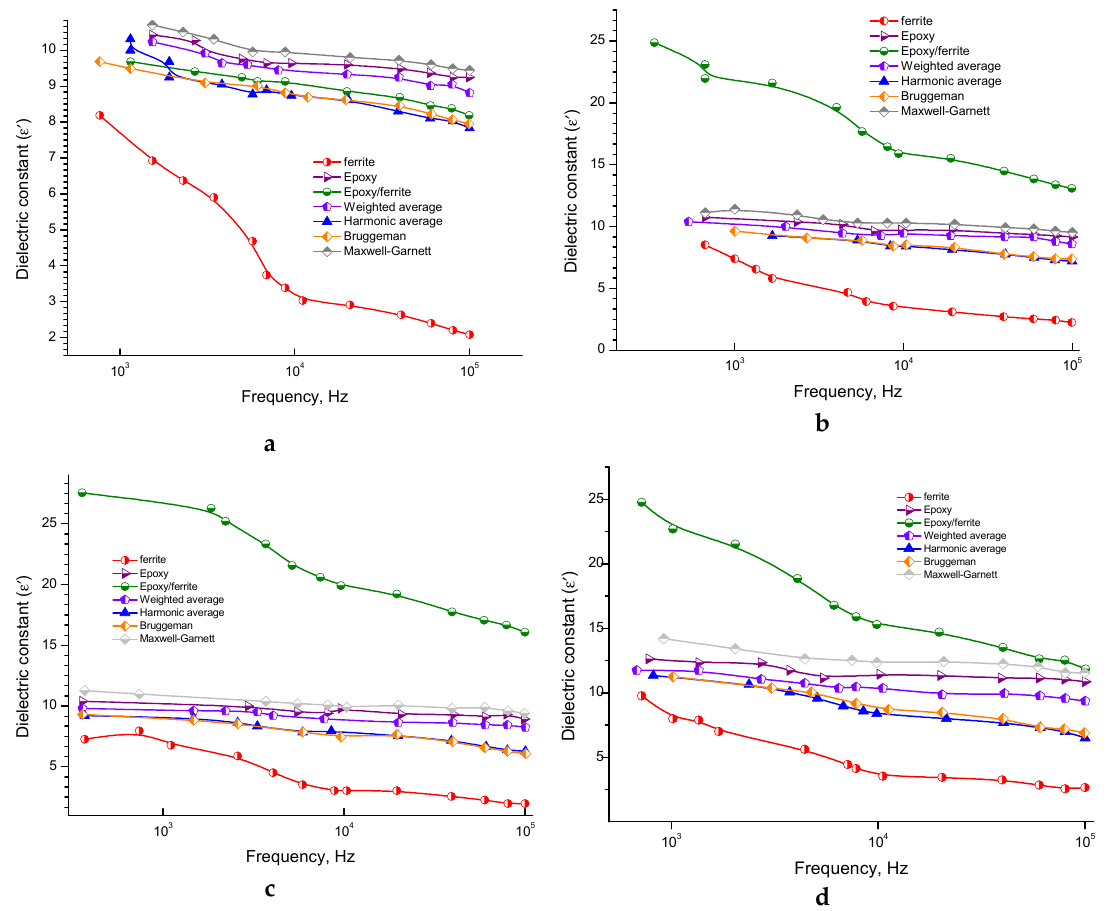
Figure 5. Modeling curves calculated in different approximations for the 20% ferrite + 80% epoxy sample ( a ), 30% ferrite + 70% epoxy ( b ), 40% ferrite + 60% epoxy ( c ), 50% ferrite + 50% epoxy ( d ) at room temperature.